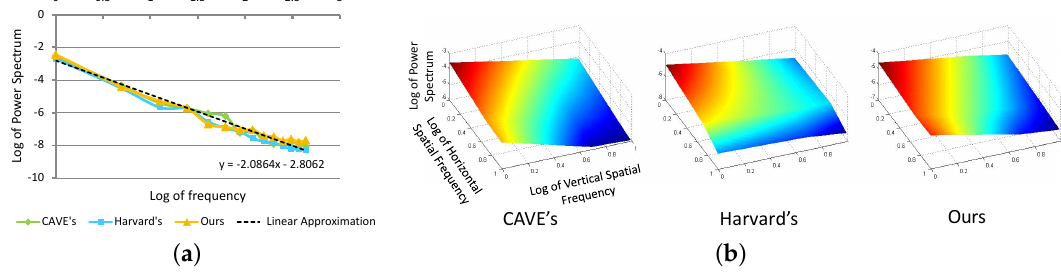
Figure 3. Spectral reflectance in four different data sets (Harvard’s [31], CAVE [38], and our dataset) have similar behavior after Fourier transform. ( a ) Log of power spectrum of spectral component in four different data sets; ( b ) log of power spectrum of spatial component in four different data